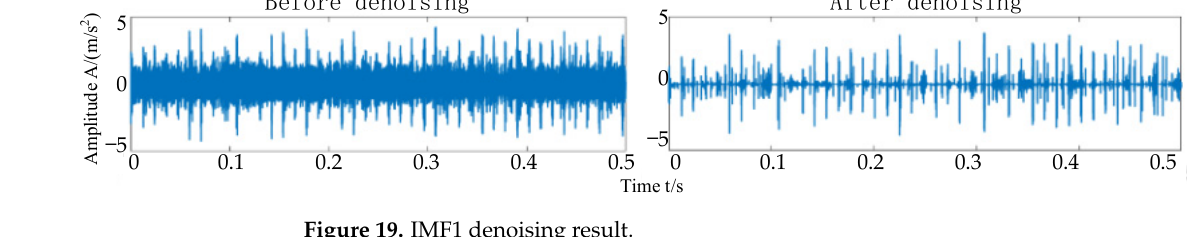
Figure 19. IMF1 denoising result.